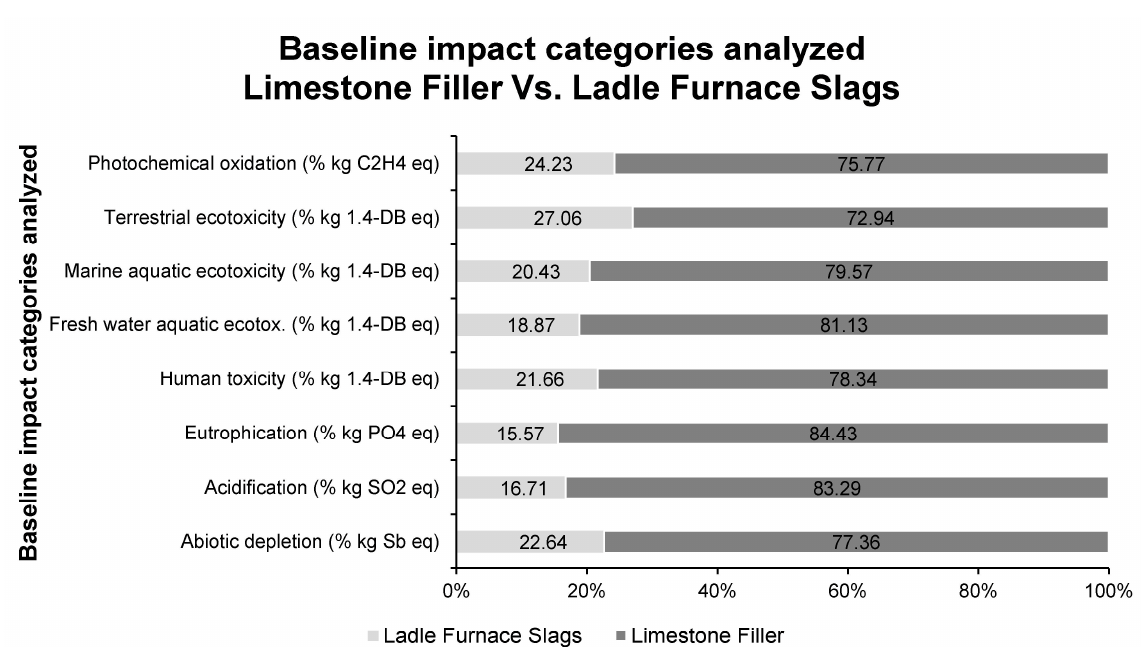
Figure 6. Percentages of emissions from various impacts for commercial limestone filler and ladle furnace slag.